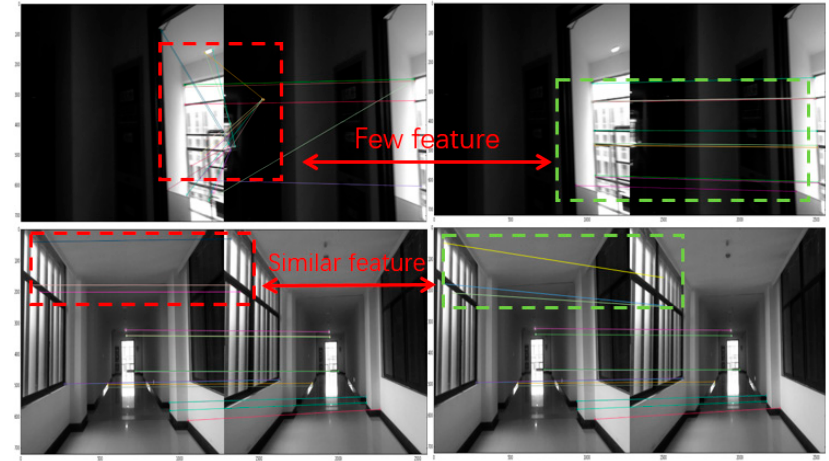
Figure 19. An illustration of wrong matching in hostile situation. Left image represented matching with all feature points in references frame and right confined matching by pre ‐ integration.